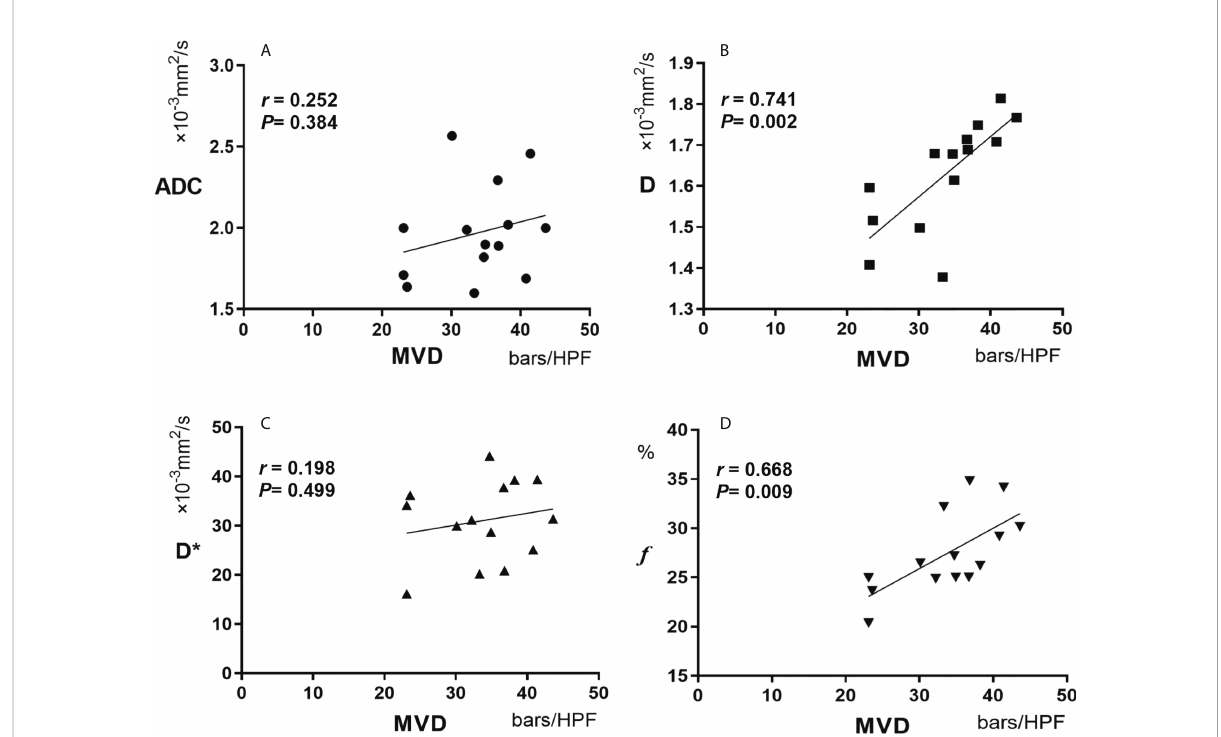
FIGURE 7 Pearson correlation between MVD and ADC (A) , D (B) , D* (C) and f (D) . MVD, microvessel